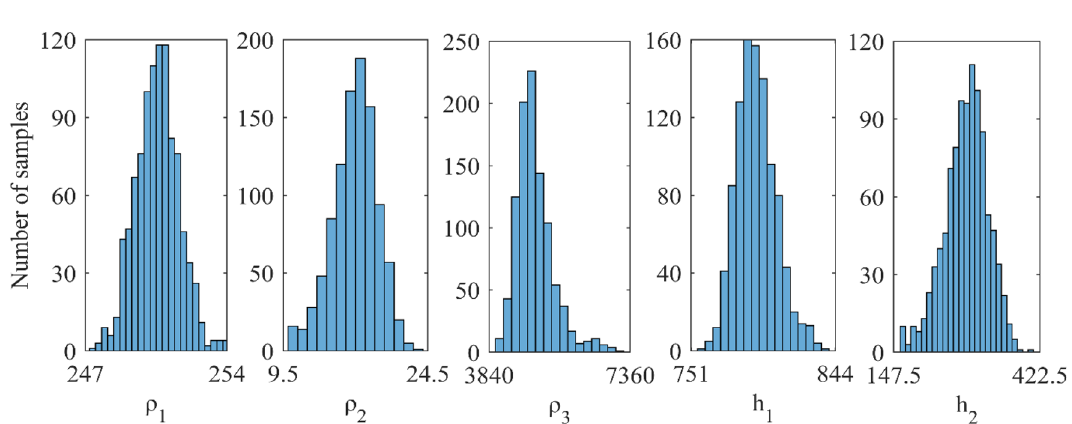
Figure 11. Bayesian posterior probability density function ( bpdf ) versus vPSOGWO inverted layer parameters for three-layered noisy DC and MT synthetic datasets.